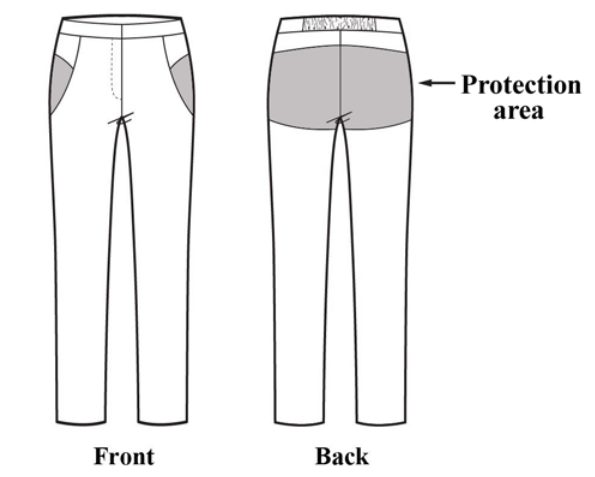
Figure 1. Design of the protective pants. Protection area is shaded.